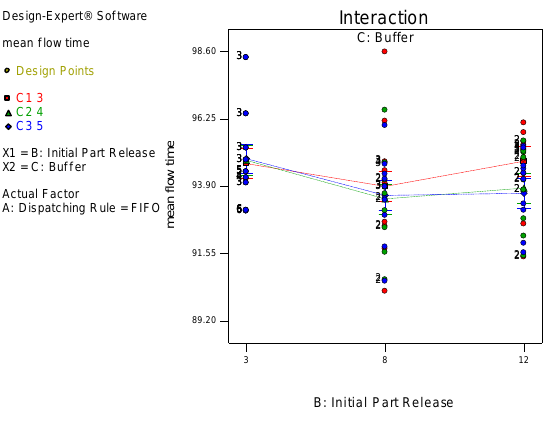
Figure 7. Average flow time, initial part release & dispatching rule